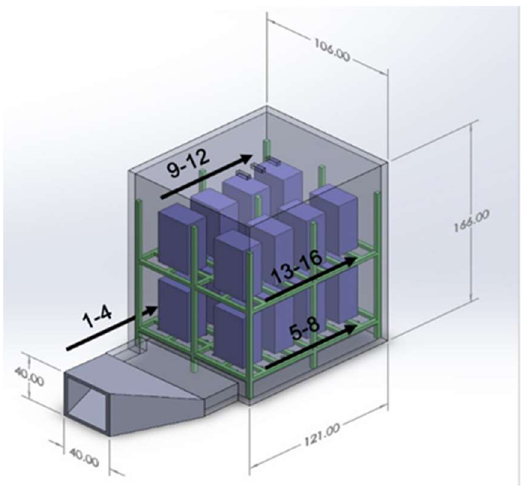
Figure 1. Model of the experimental design. The battery number assignments shown are consistent through all designs and models within this work. Dimensions are in millimeters. The full-size model used in simulation is shown in Figure 2. Battery